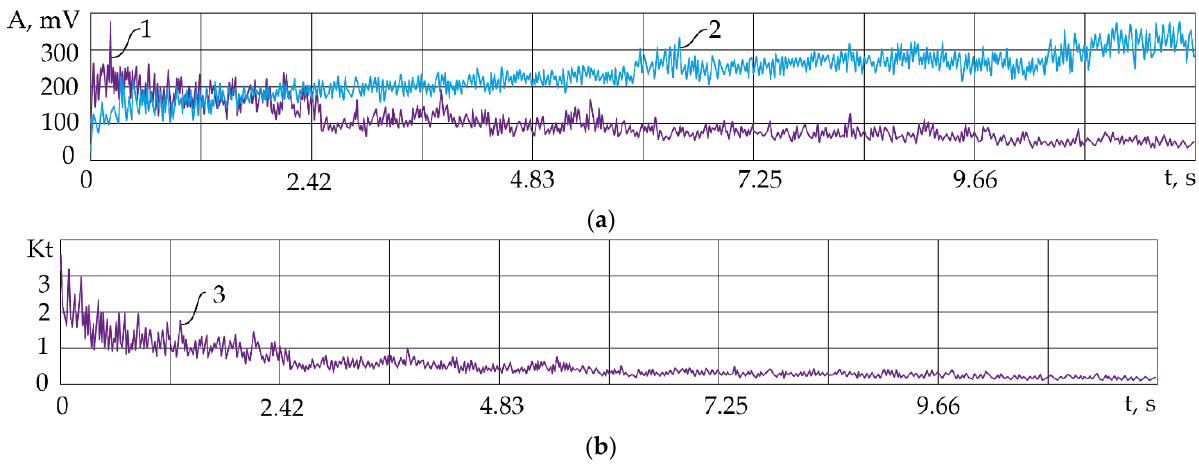
Figure 5. Changes in the RMS amplitudes of the AE signals in the range of 10 – 20 kHz (curve 1, ( a )), current (curve 2 ( a )) and the transfer coefficient Kt (curve 3 ( b )) during the period between beginning of operation and the electrode breakage.